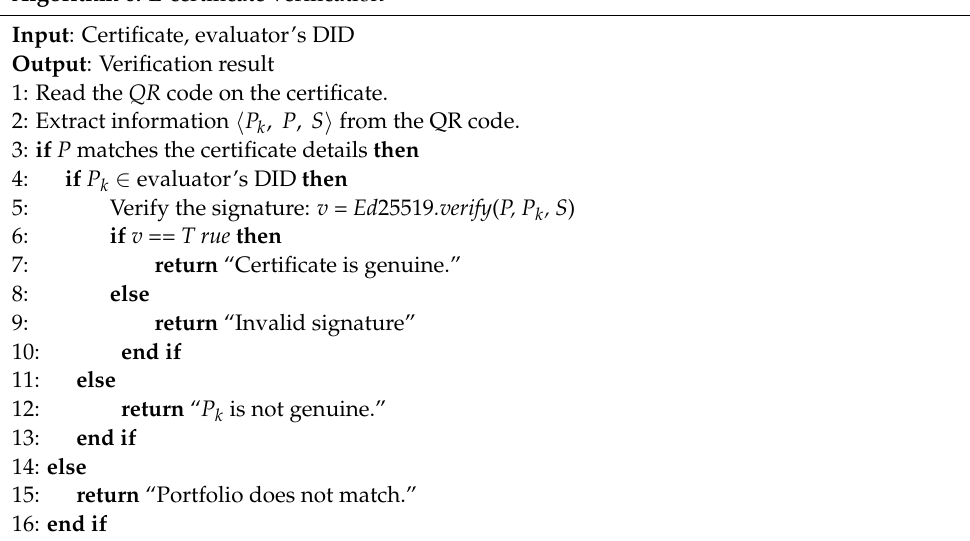
Algorithm 6. E-certificate